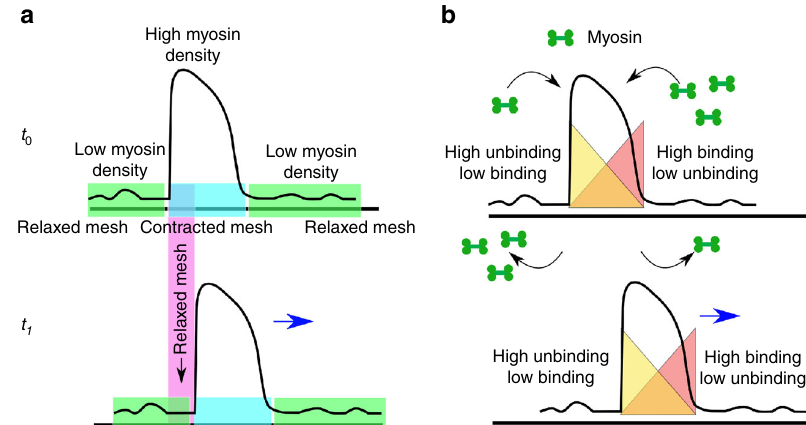
Fig. 6 Possible mechanisms for the movement of actomyosin-dense structures in an active af fi ne elastomer: a moving deformation of the actomyosin mesh without turnover, implying a traveling front, and b moving deformation of the actomyosin mesh with differential myosin binding unbind rates at the leading and trailing edges of the